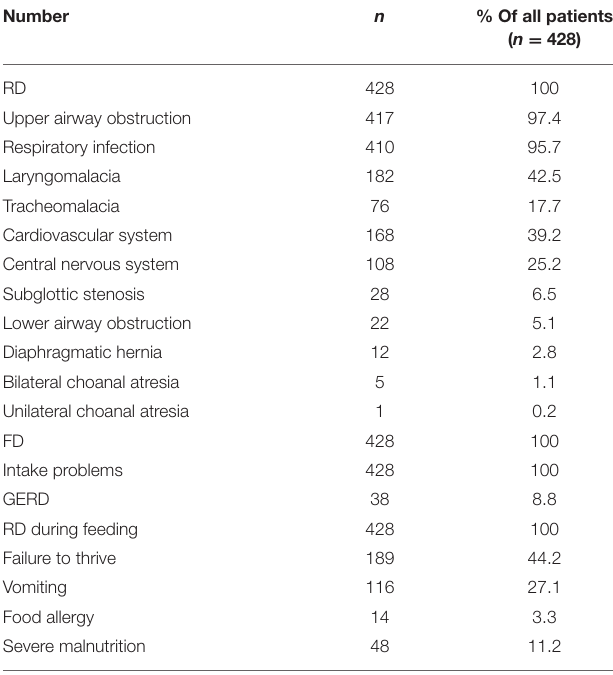
TABLE 1 | Presentation of respiratory, feeding difficulties, and other